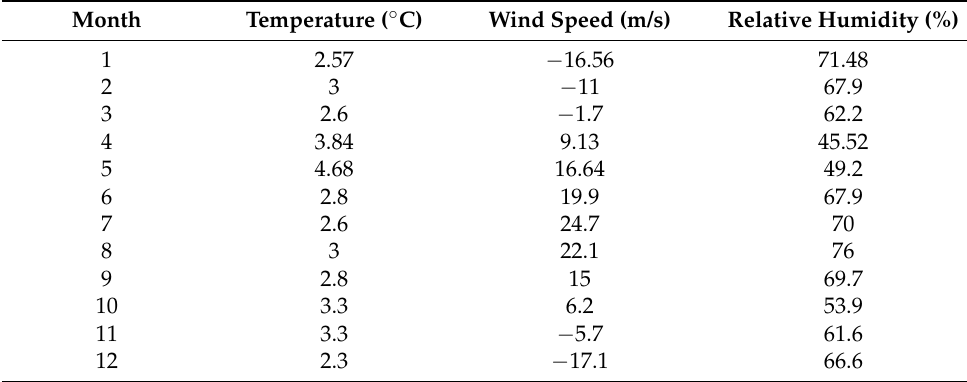
Table 6. Parameter setting of climate